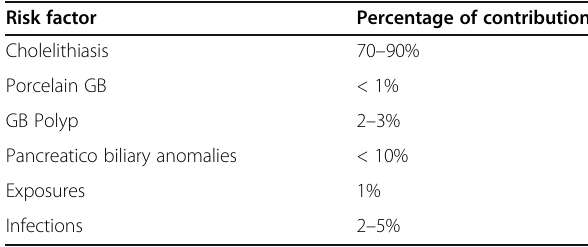
Table 2 Risk factor and percentage of